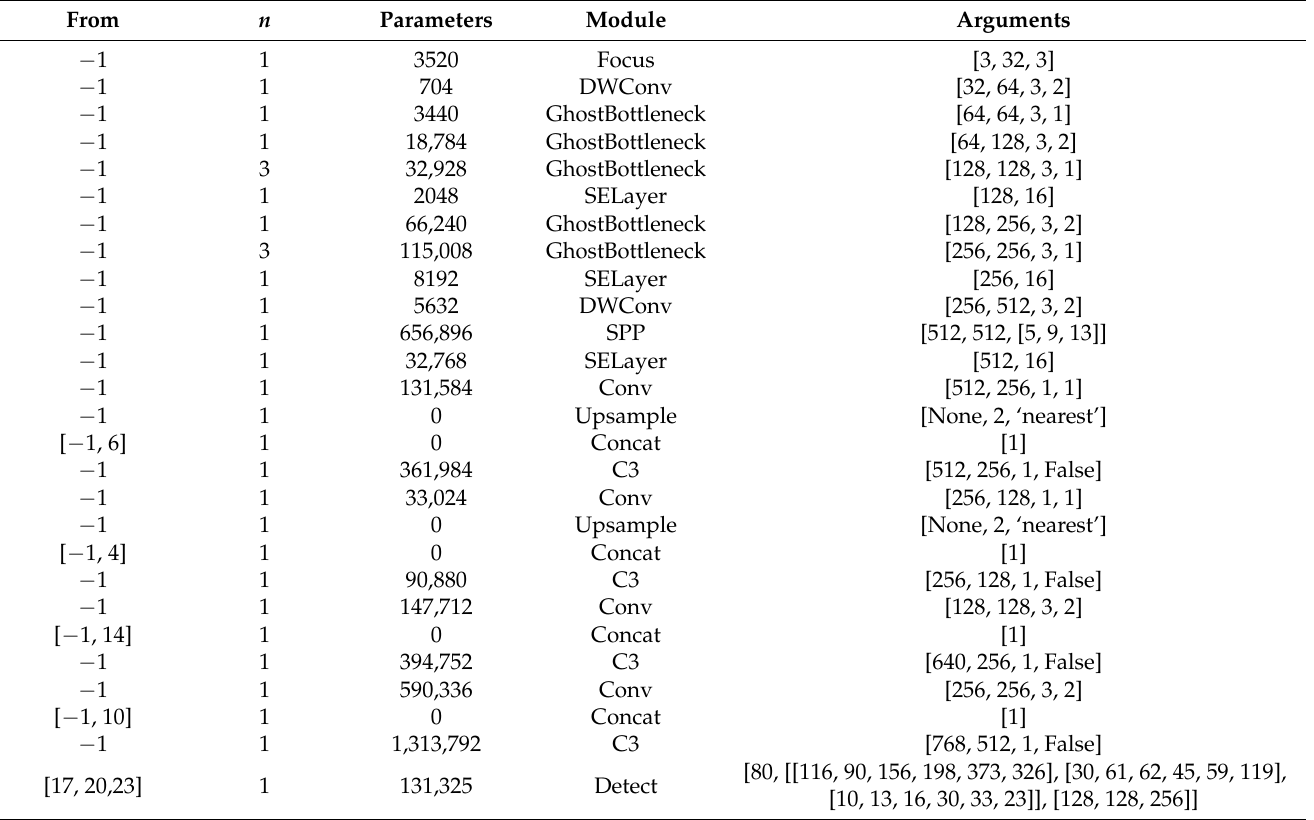
Table 3. The summary of the improved Yolov5s